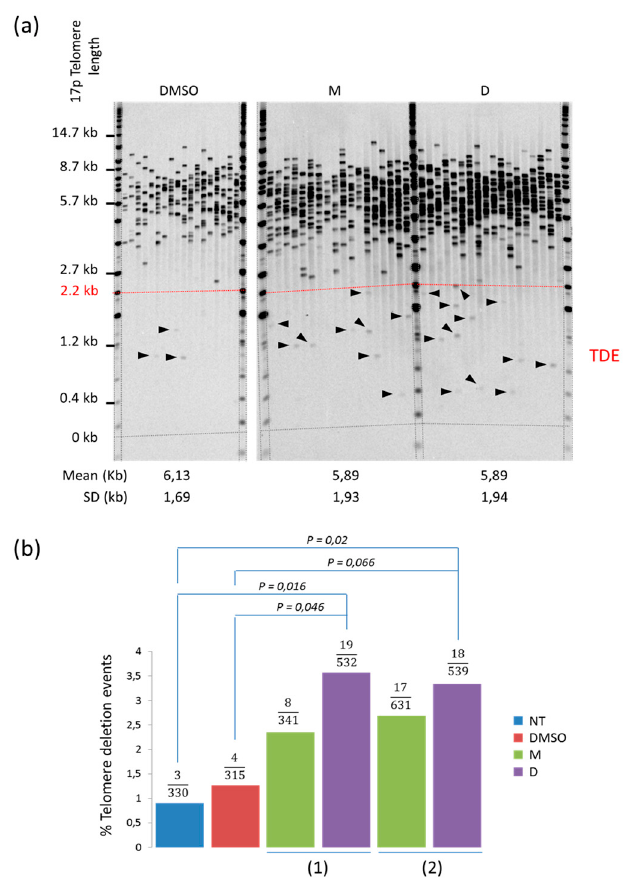
Figure 3. 360A and (360A) 2A induced telomere deletion events in A549 cells: ( a ) Representative experiment (from experiment (2)) of the scaled up STELA at 17p telomere in the last PD points of A549 treated with 5 µ M of 360A (M) or 5 µ M of (360A) 2A (D). Each lane represents a PCR and each band a telomere; ( b ) Histograms showing the proportion of TDEs in 2 independent experiments in the last PD points (i.e., at day 11 for both 360A and (360A) 2A in experiment 1; and at day 11 and 8 for 360A and (360A) 2A , respectively, in experiment 2) of A549 treated with 5 µ M of 360A (M) or 5 µ M of (360A) 2A (D). The Chi-square test was used to determine the p values.